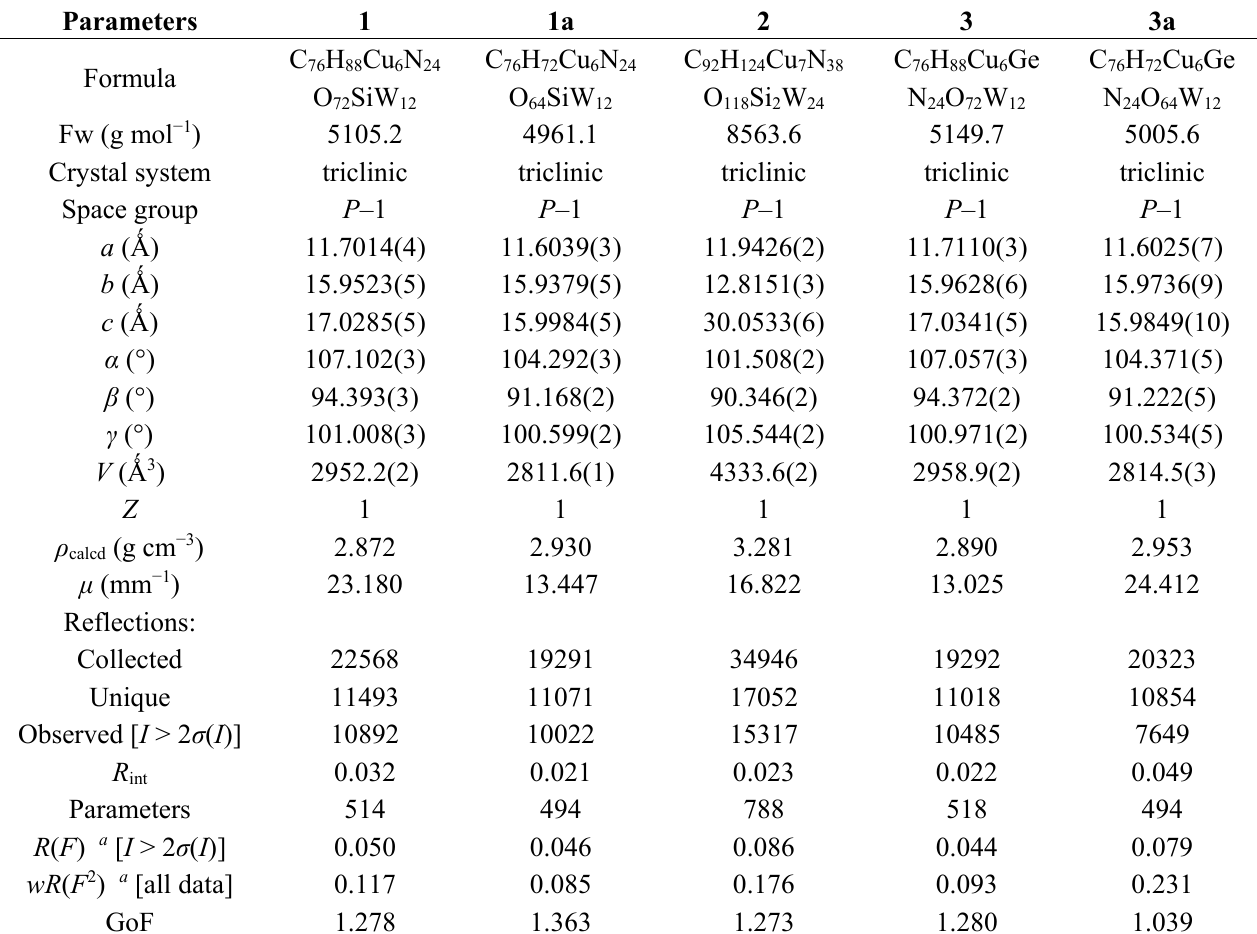
Table 4. Crystallographic data for 1 – 3 and for the anhydrous phases 1a and 3a